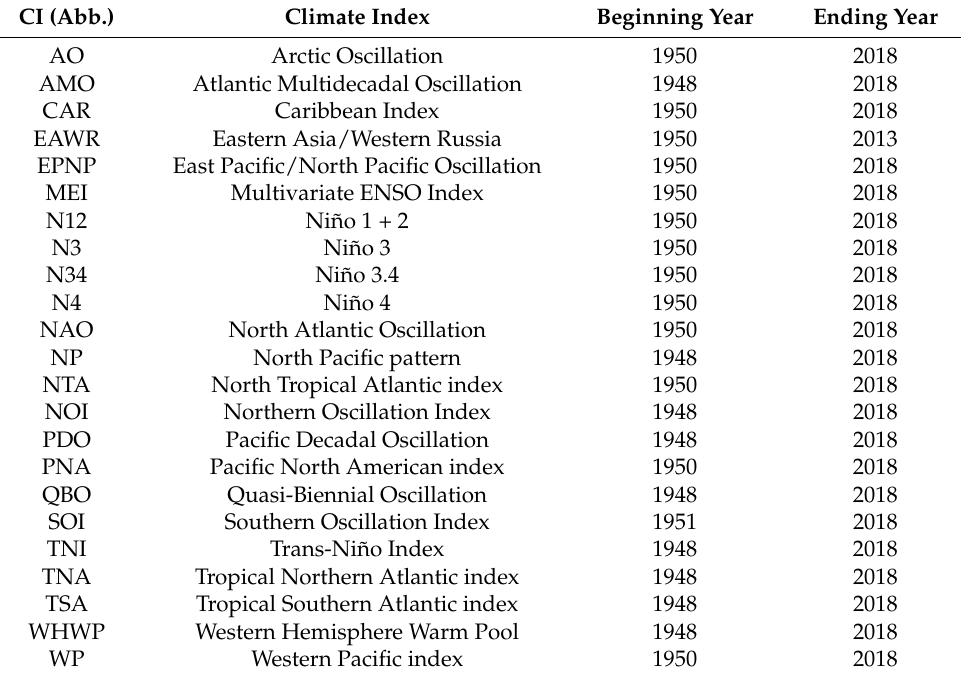
Table 1. CIs (abbreviations and names) assessed along with their respective periods of record. Detailed definitions of each climate index can be found at NOAA